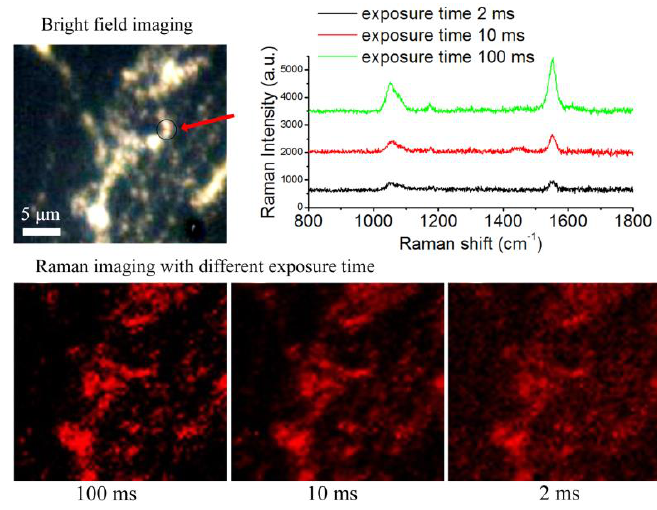
Figure 8. The SERS imaging result of BGERTs in different exposure times.